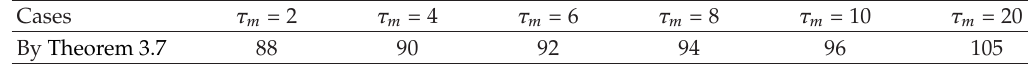
M for given τ m